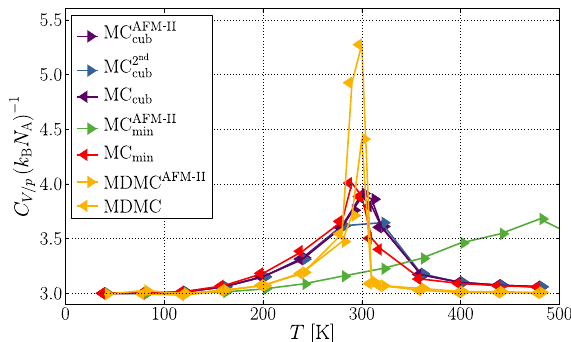
Fig. 3 Temperature dependence of the heat capacity. Molar heat capacity at constant volume C V (MC) and pressure C p (MDMC) divided by the Boltzmann constant k B and the Avogadro constant N A as a function of the temperature T obtained in different simulation methods for 6 × 6 × 6 MnO supercells. The superscript of the simulation method de fi nes the initial magnetic con fi guration (cubic AFM-II or second global minimum), otherwise random initial magnetic orders are used. The subscript cub indicates the restriction to the cubic lattice with a exp = 4.430 Å and the subscript min indicates an optimization of the initial structure prior to the MC